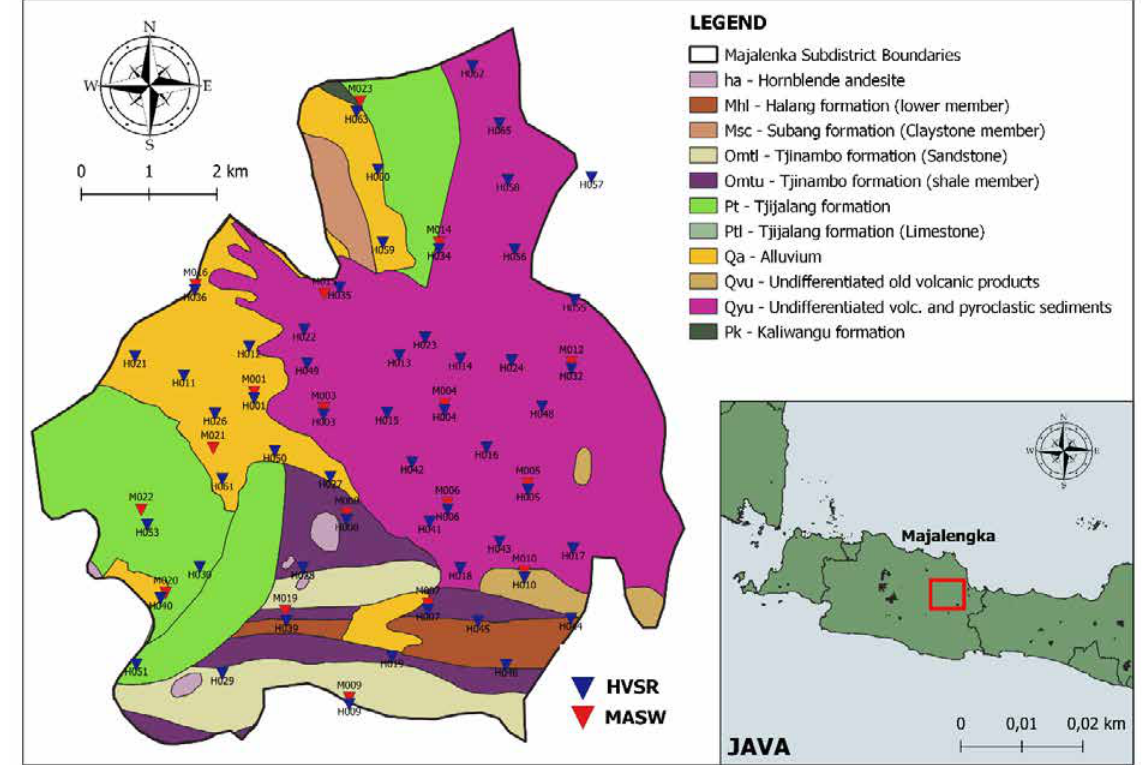
Fig. 2: Geology map of Majalengka (Modified from Djuri, 1995). The location of Majalengka on Java Island is shown in Fig. 1. The locations of the seismic experiments are indicated by red and blue triangles.